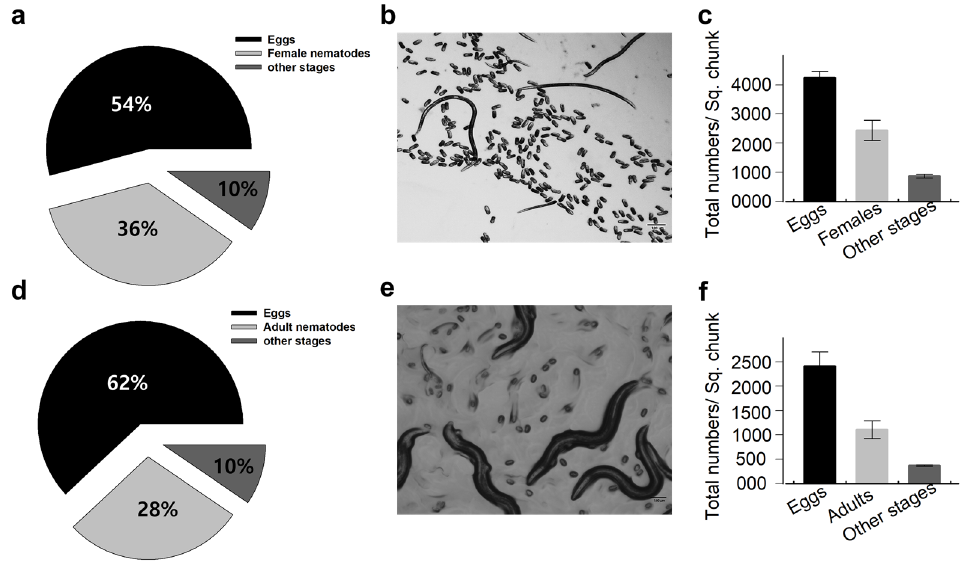
Figure 3. B. xylophilus egg counts in fungal lawns and of Caenorhabditis elegans [ fer-15 ( b26 ); fem-1 ( hc17 )] egg counts in bacterial lawn. ( a ) Pie chart showing the percentage of ( a ) B. xylophilus ; ( d ) C. elegans adults, eggs, and other stages. ( b ) Representative microscopic image of B. xylophilus ; ( e ) C. elegans eggs with few nematodes that settled at the bottom of the microtiter plate. ( c ) Estimate of the B. xylophilus ; ( f ) C. elegans eggs, and nematode stages isolated by the current method.